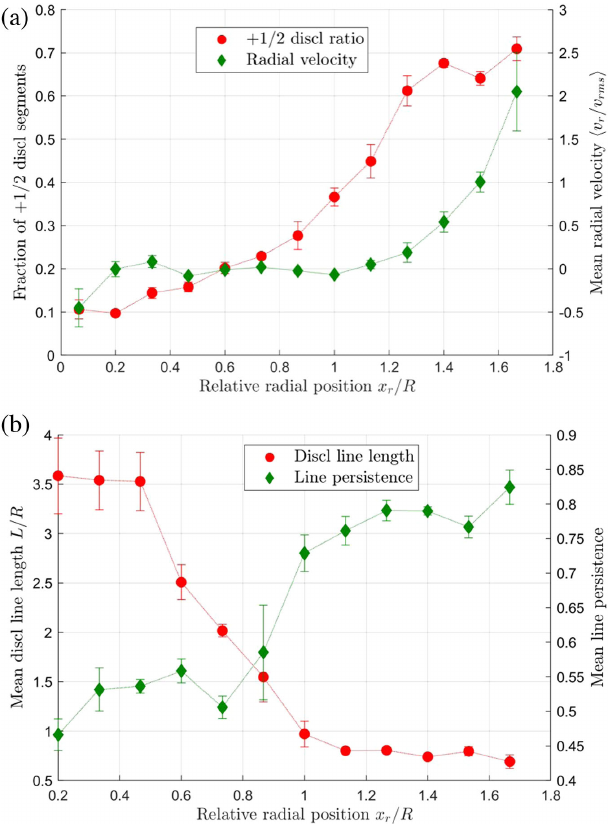
FIG. 10. Disclination line properties for extensile activity as a function of radial position x r in an initially spherical droplet of radius R . (a) Most of the disclination lines in protrusions ( x r > R ) show a þ 1 = 2 director configuration for which the self-propulsion velocity v r points radially outward. (b) Disclination lines in protrusions ( x r > R ) are nearly straight lines whose length is limited by the diameter of the protrusion. The radial component of the self-propulsion velocity v r is obtained by taking the droplet ’ s center of mass as the reference point of a spherical coordinate system. The fraction of þ 1 = 2 disclination lines is defined as the fraction of disclination line segments with twist angle 3 = 4 π ≤ β ≤ π and the persistence of disclination lines as the ratio of end point distance over total line length. Disclination line properties are calculated by sorting observations f Y g into bins of range X i (cid:3) h= 2 . The position of error bars shows the bin mean hf Y i gi , and the size of error bars indicates the standard ffiffiffiffiffi p N error of the mean ϵ ¼ std ðf Y i gÞ = , where N i is the number of i observations in bin X i (cid:3) h= 2 . The averaging is performed over T ¼ 100 000 time steps, which is much longer than the mor- phological timescale on which protrusion formation happens (approximately 2000 time steps; see Fig.